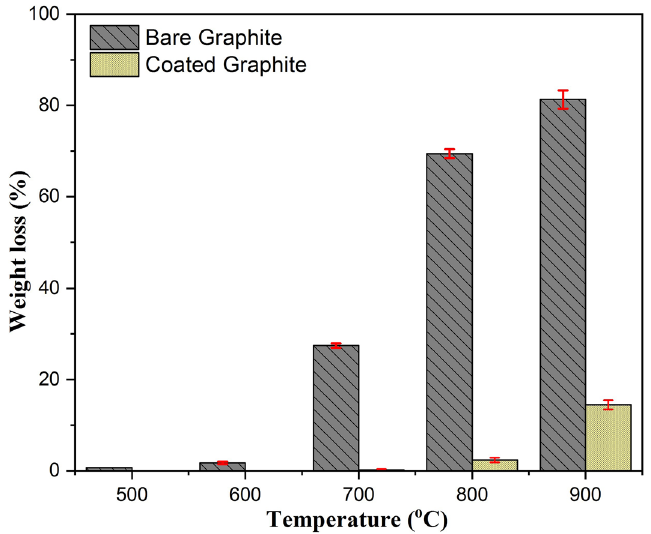
Figure 7. Weight loss percentage in bare and coated graphite specimens after oxidation for 2